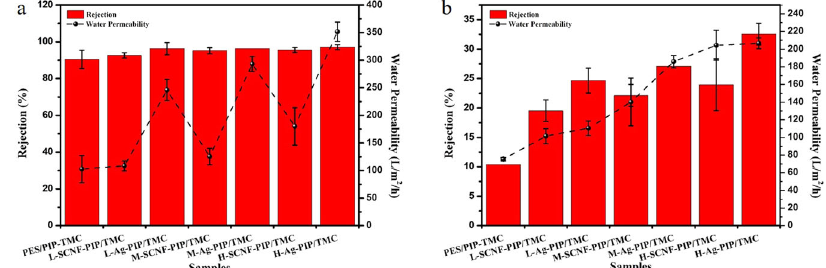
Fig. 7 Rejection and water permeability of composite NF membrane for Na 2 SO 4 and NaCl. a Rejection and water permeability of composite NF membrane for Na 2 SO 4 , b Rejection and water permeability of composite NF membrane for NaCl. Error bars represent standard deviations using at least two measurements from two different